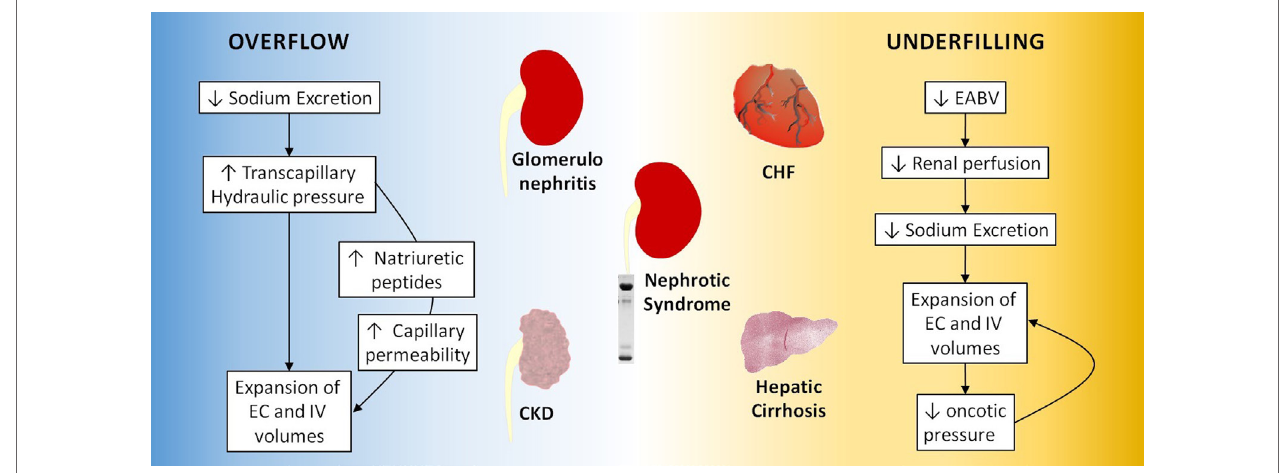
FiGURe 1 | Overflow and underfilling mechanisms in edematous states. CKD, chronic kidney disease; EC, extracellular; IV, intravascular; CHF, congestive heart